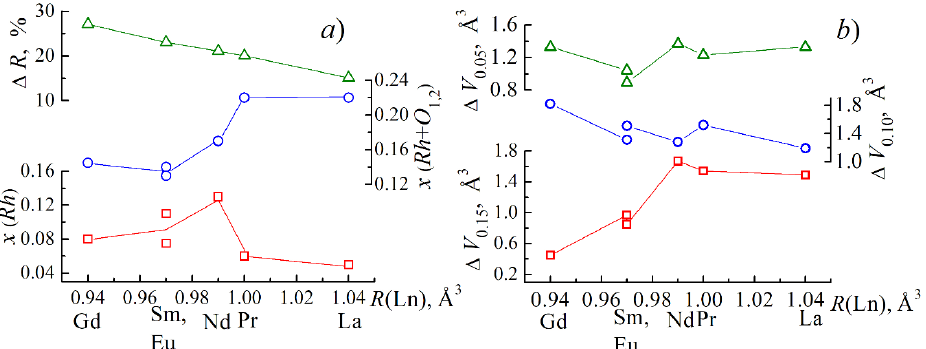
Figure 8. Dependences of the position of the boundary ( x ) of the existence of a pure Rh -phase, its mixture with O 1,2 -phases, the relative difference between R Bi and R REE ( Δ R ) on the radius, R , of REE ( a ); ( b ) Dependences of the difference between V exp. and V theor. ( Δ V ) on the ionic radius, R , REE in SS with x = 0.05, 0.10, 0.15.